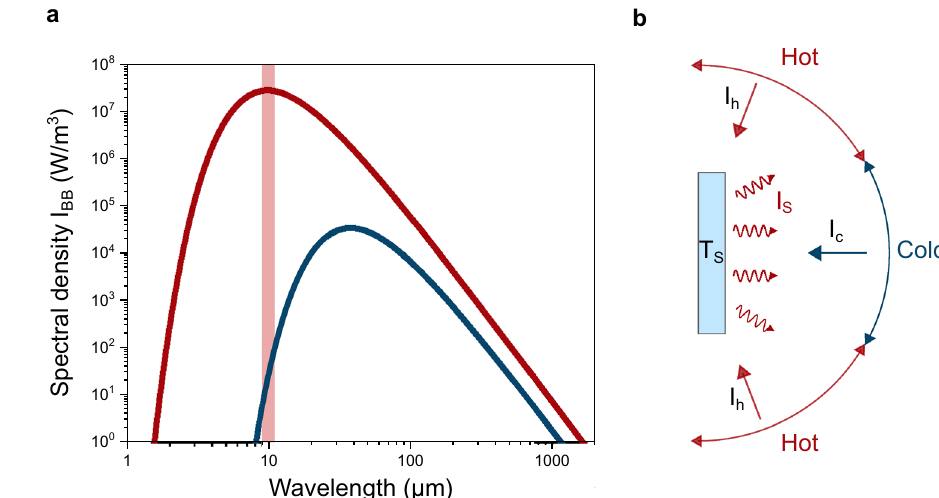
Figure 1. Black body emission and view factor. ( a ) Blackbody radiation spectra at room temperature (red curve) and at liquid nitrogen temperature (blue curve). The light red bar indicates the wavelength range relevant for this work (9–11 µm). ( b ) While a sample will always emit thermal energy homogeneously within the solid angle of a half-sphere, the amount of incident hot and cold radiation will determine the temperature distribution on the sample. By tuning the view factor of hot and cold radiation over the solid angle, the temperature profile can be manipulated. The sample is at a temperature T S and emits radiation with intensity I S . The hot sections of the solid angle environment emit with intensity I h and the cold section with I C